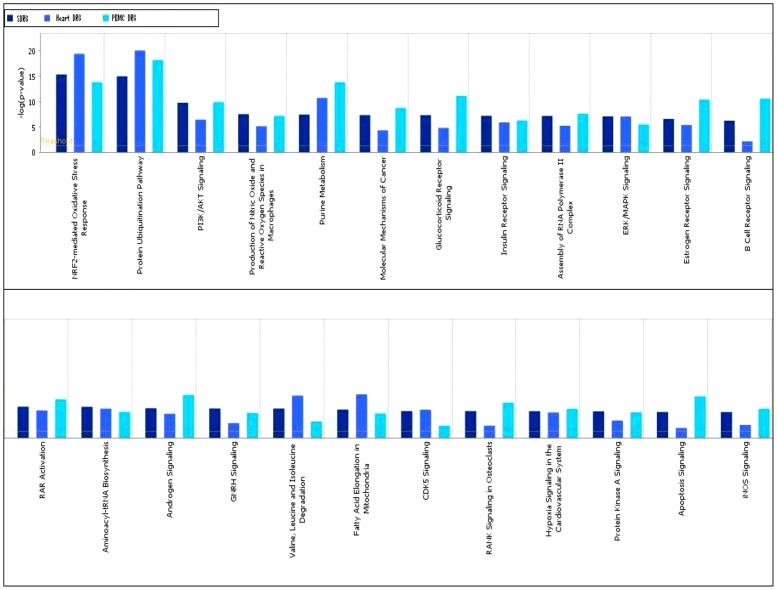
Global Canonical Pathway analysis and comparison of the most significantly enriched canonical pathways that were significantly differentially regulated in the heart vs cont, PBMC vs cont and SDRG datasets.Data sets were analyzed by the IPA software (Ingenuity® Systems, http://www.ingenuity.com). The significance is expressed as a P-value, which was calculated using the right-tailed Fisher's Exact Test. Threshold: P<0.05. The full size figure is available as Figure S1.